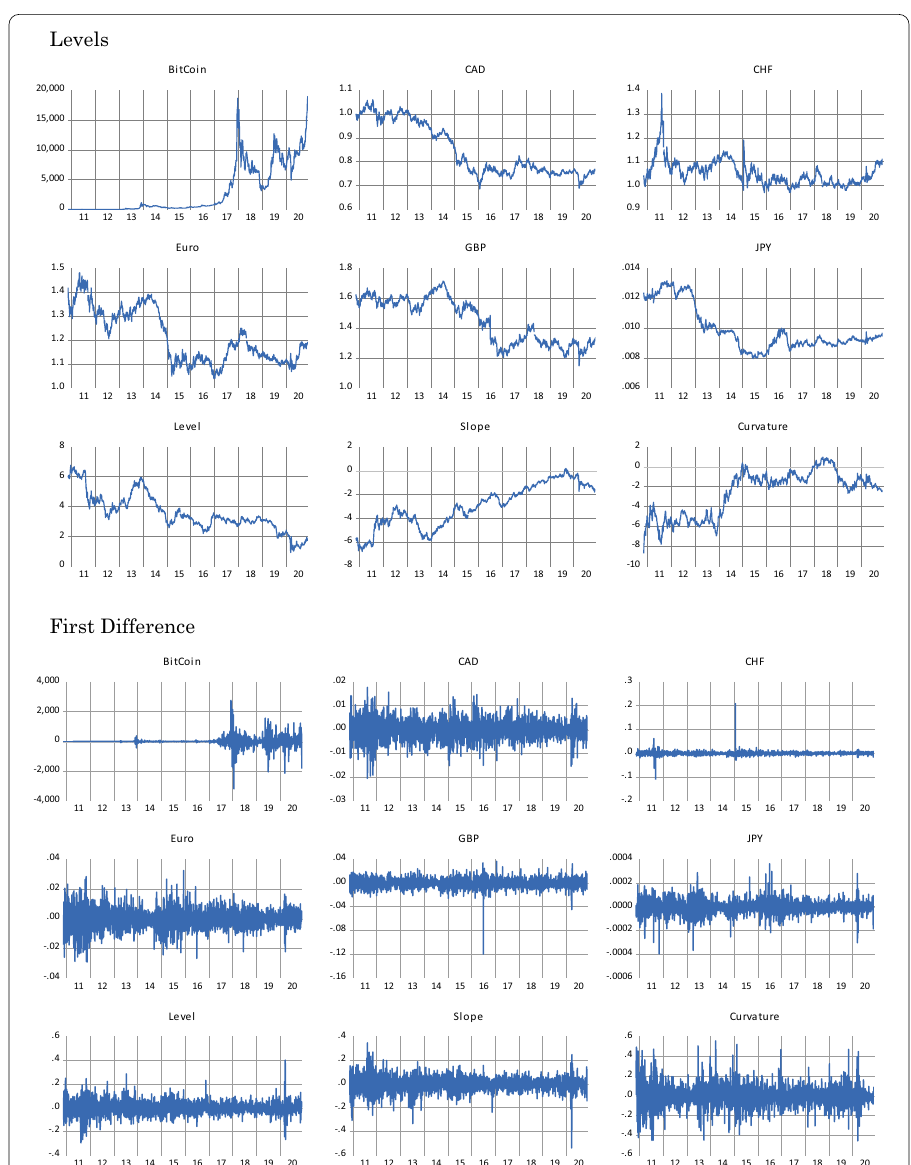
Fig. 4 Levels and First Difference of the Exchange Rates and the Components of the Yield Curve. Notes : This figure shows the level and first difference of the exchange rate of Bitcoin and the fiat currencies in the top and bottom panels, respectively. The levels and first difference of the components of the yield curve are also